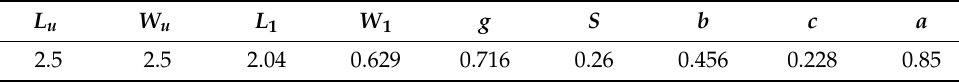
Figure 7. ENZ metamaterial unit cell and results. ( a ) Geometry of the unit cell. ( b ) S − parameters of the unit cell versus frequency. ( c ) Real and imaginary unit cell permittivity versus frequency. Table 2. Optimum dimensions of the ENZ metamaterial unit cell in mm.